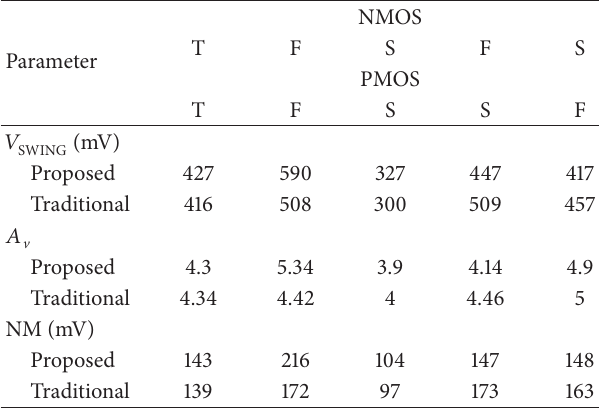
Table 2: Effect of process variation on static parameters of the proposed and the traditional